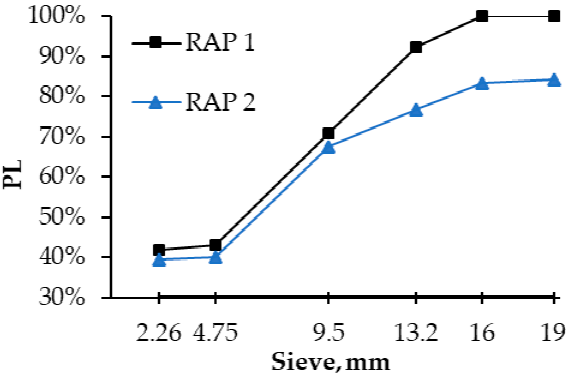
Figure 5. Percentage Loss ( PL ) Rate of Each Particle Size after Extraction Test.